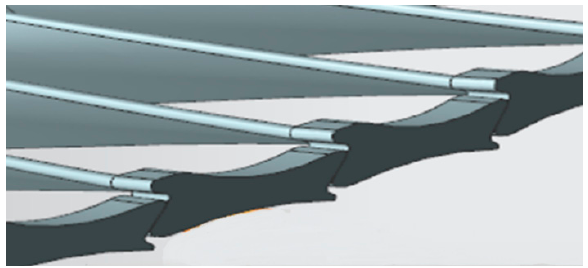
Figure 1. Shrouded blades of the last stage in a steam turbine.